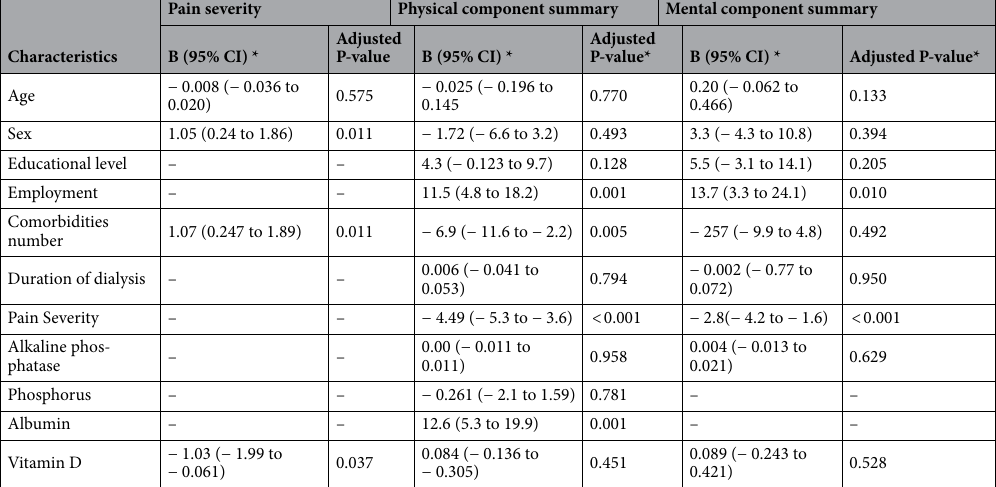
Table 4. Linear regression analysis for predictors of PCS and MCS domains of SF-36 and Pain severity. PCS physical component summary, MCS mental component summary. *Unstandardized coefficients and its 95.0% confidence